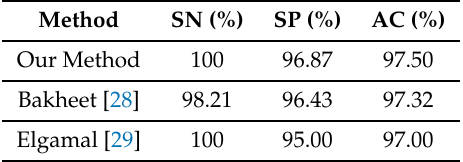
Table 2. Comparison of our methodology with other state-of-the-art